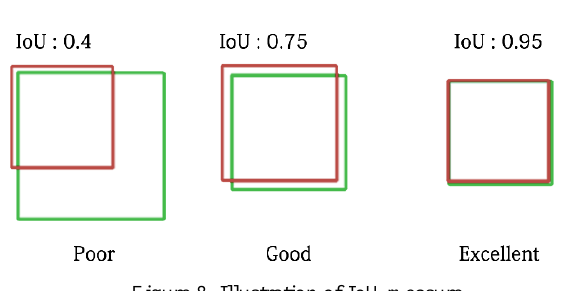
Figure 11. Detection results of detachment.